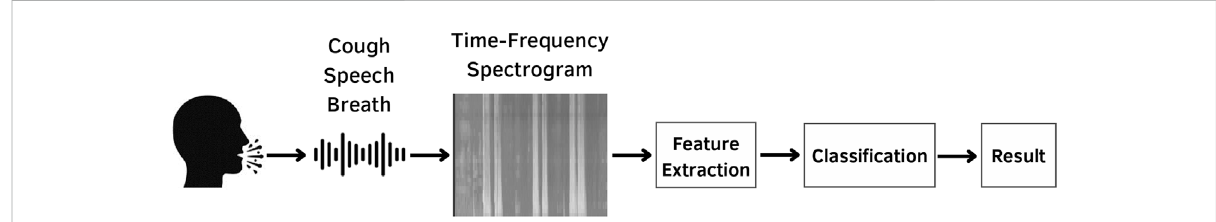
FIGURE 1 Proposed scheme for COVID-19 screening using cough, speech, and breath sounds.